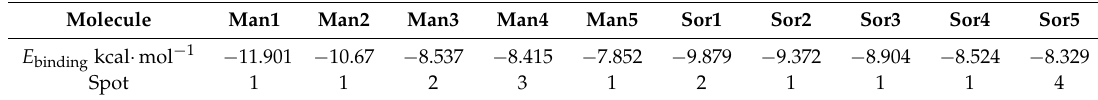
Table 4. Binding affinity and hotspot for the lowest energy solutions found for polysorbate 20 and 80 solutions.